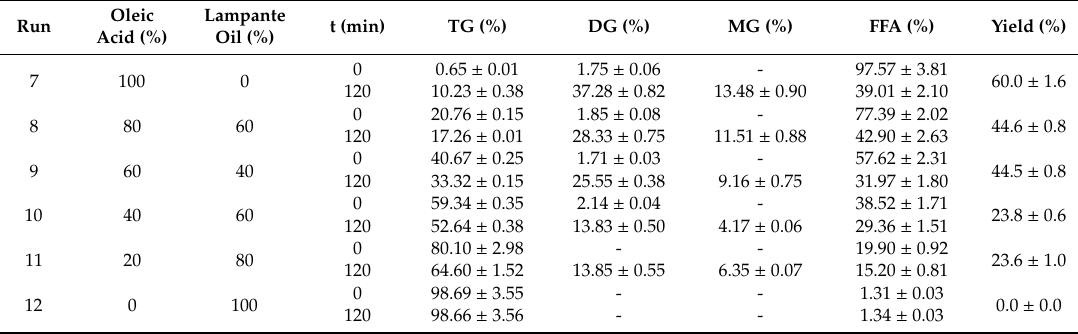
Table 4. Triglyceride (TG), diglyceride (DG), monoglyceride (MG) and free fatty acid (FFA) content of the mixtures of oleic acid and lampante olive oil mixtures obtained by HPSEC at the beginning and at the end of the esterification reactions, and conversion yields (mean ± SD, n = 2).